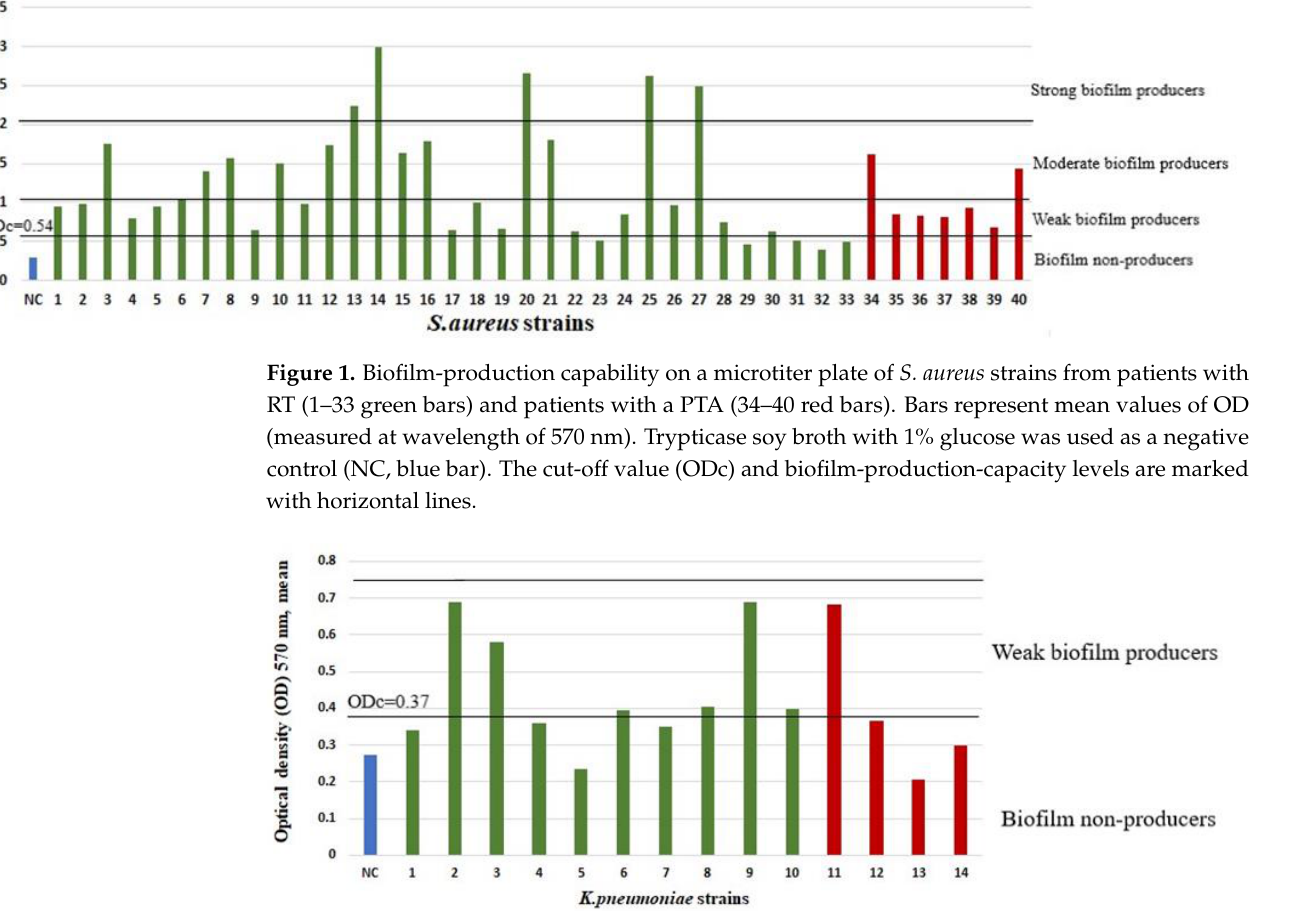
Figure 2. Biofilm-production capability on a microtiter plate of K. pneumoniae strains from patients with RT (1–10 green bars) and patients with a PTA (11–14 red bars). Bars represent mean values of OD (measured at wavelength of 570 nm). Luria–Bertani medium was used as a negative control (NC, blue bar). The cut-off value (ODc) and biofilm-production-capacity levels are marked with horizontal lines. Table 2. Comparison of patients’ microbiological data in the RT and PTA groups.